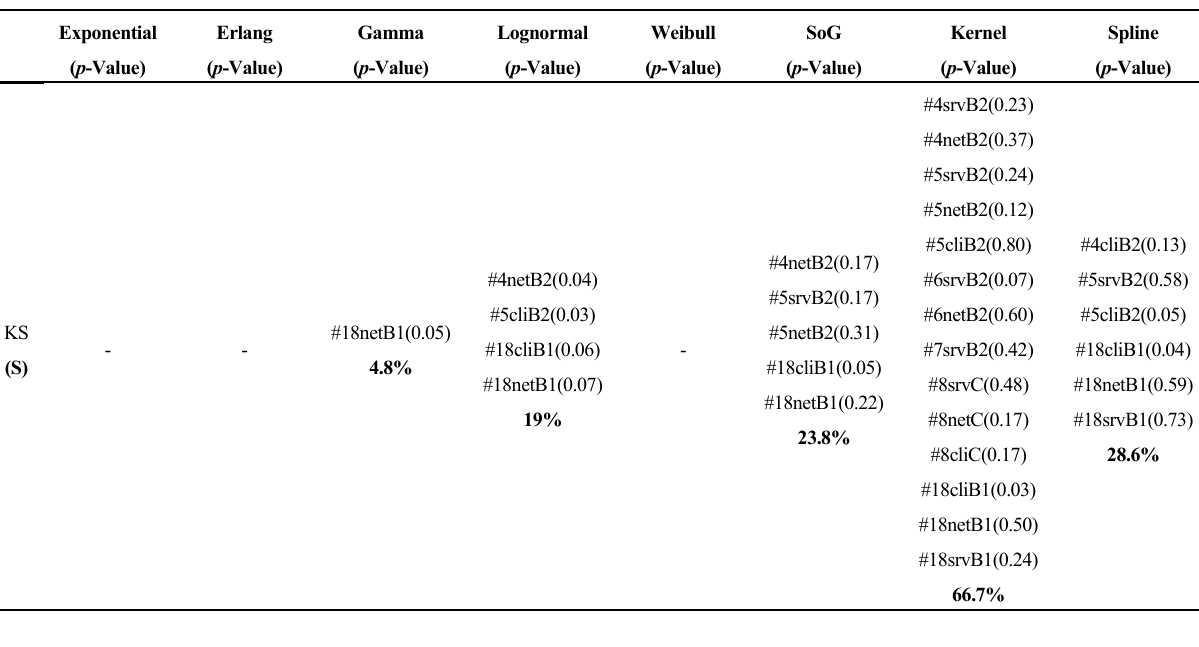
Figure 6. Illustrative histograms and fittings for the scenarios that can be modeled successfully after the splitting of delays (see Table 5).